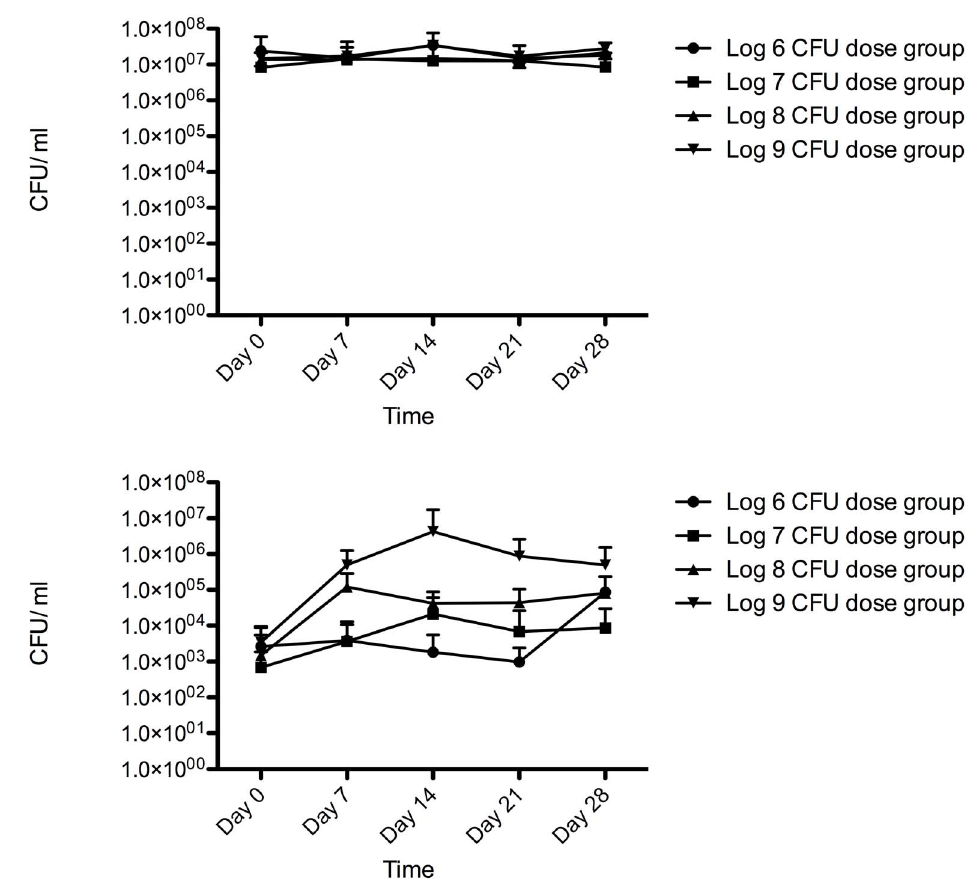
Figure 2. a. Streptococcussalivarius colony forming units obtained on Mitis Salivarius agar over duration of the study from the saliva of subjects that received differing doses of S.salivarius M18 (error bars denote ± SD). b. Streptococcus salivarius colony forming units obtained on Mitis Salivarius agar containing streptomycin as also used as a selective marker for the probiotic strain (error bars denote 6 SD).